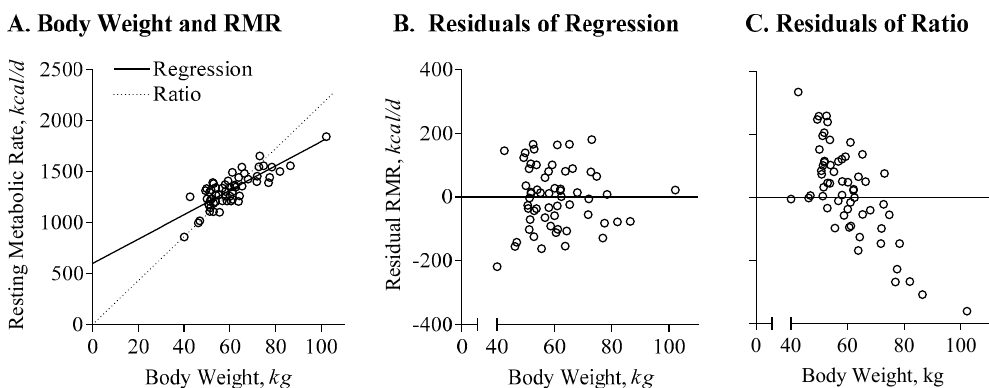
Figure 1. Appropriate adjustment of energy-expenditure data. ( A ) The association between body weight and resting metabolic rate is characterized by linear regression (solid line, RMR[ kcal / d ] = 598 + 11.97 × BW[ kg ], R 2 = 0.66) and ratio (pointed line, RMR[ kcal / d ] = 21.56 × BW[ kg ], R 2 = 0.22); of note, logarithmic or polynomial approximations do not improve the prediction of RMR (for both, R 2 = 0.67). ( B ) Residual resting metabolic rate (RMR), calculated as measured RMR minus predicted RMR; based on the regression equation in ( A ); the residuals show no structural over- or underestimate based on body weight. ( C ) Residual RMR, based on the ratio equation; women with increased body weight have significant lower residual RMR, and would be considered as having a low adjusted metabolic rate.